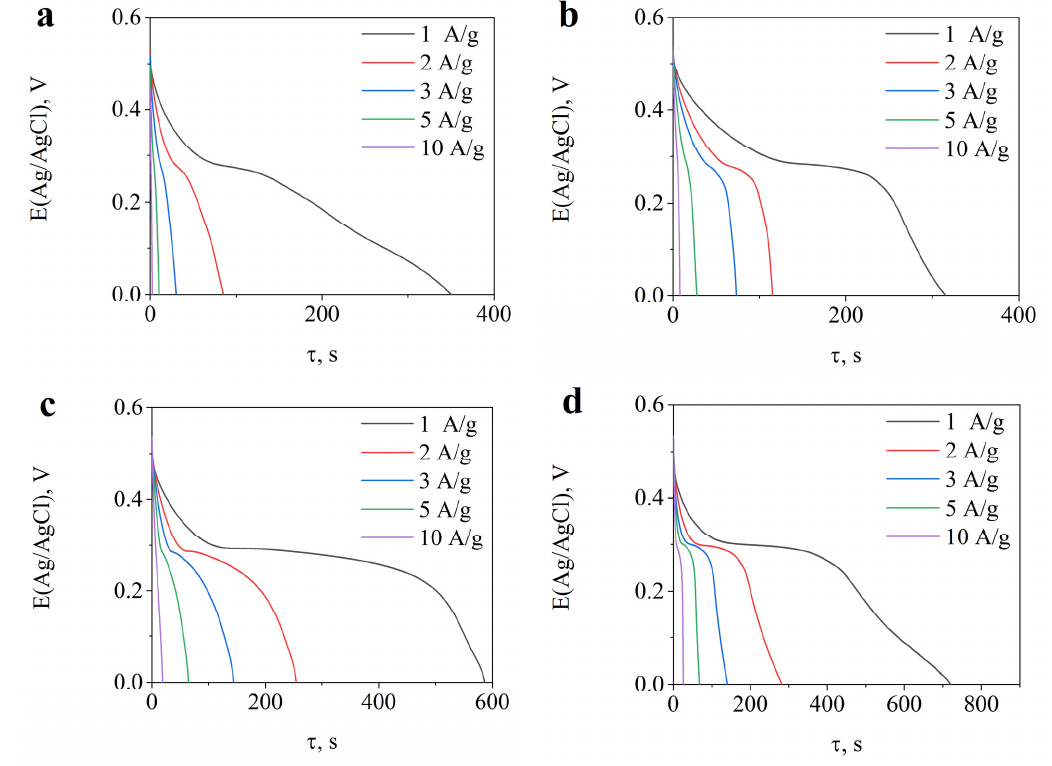
Figure 10. Discharge curves at the different current densities for: ( a ) Ni(OH) 2 -pure; ( b ) Ni(OH) 2 -PVP; ( c ) Ni(OH) 2 -PVP-Co-elchem; ( d ) Ni(OH) 2 -PVP-Co-chem.